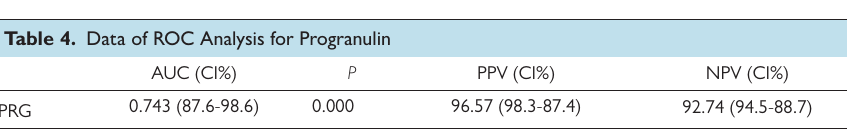
Table 4. Data of ROC Analysis for